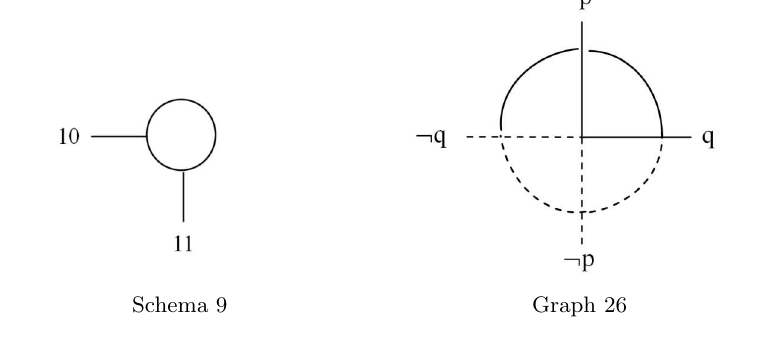
Schema 9 stands for a two-place basic formula: ⌊ p q ⌋ (pq), which means that ‘p’ is true (has value 1) and ‘q’ is false (has value 0), or